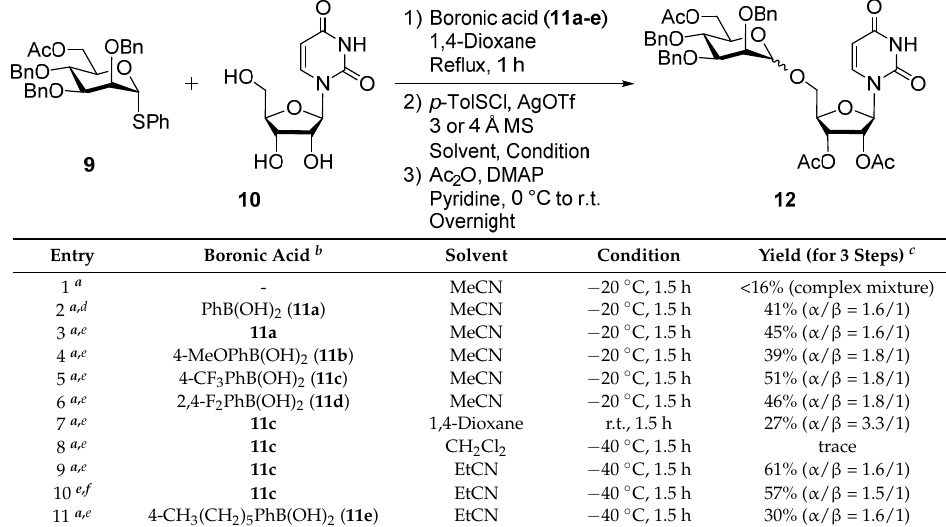
Table 1. O -glycosylation of uridine 10 with the thiomannoside 9 in the absence and presence of boronic acid.